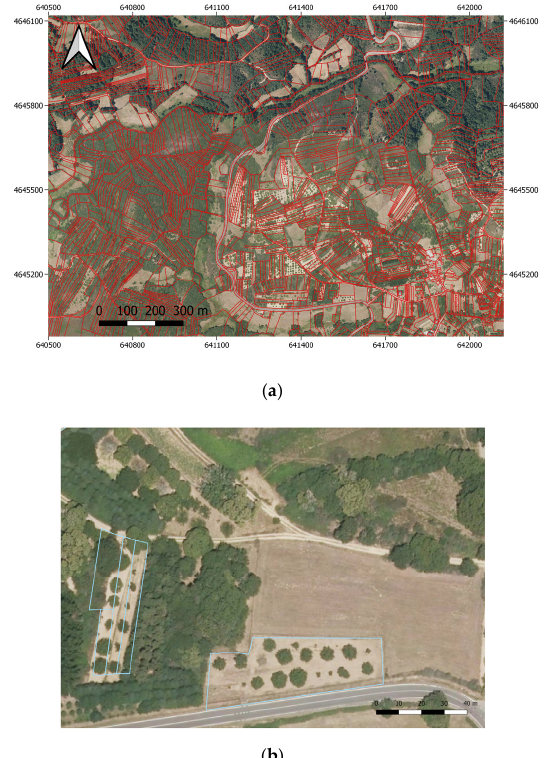
Figure 2. Chestnut plantations in the study area: ( a ) global view of the general structure of rural land tenure. Red lines delimit agricultural and forest cadastral plots. Coordinate system ETRS89 29N; ( b ) detailed view of chestnut plantations parcels. Parcels with blue contour are chestnut plantations parcels, while the rest of the area presents di ff erent land-covers. (Reference image: National Air Orthophotography Program (PNOA) image)